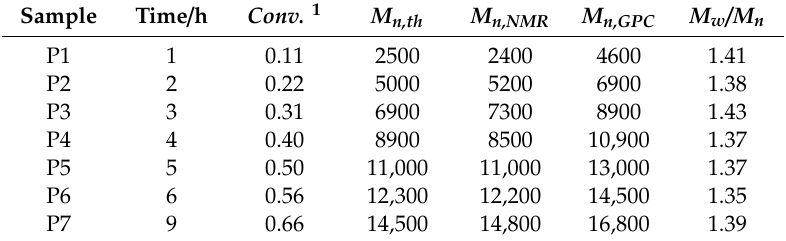
Table 1. Results of RAFT / MADIX copolymerization of CTFE and BVE.